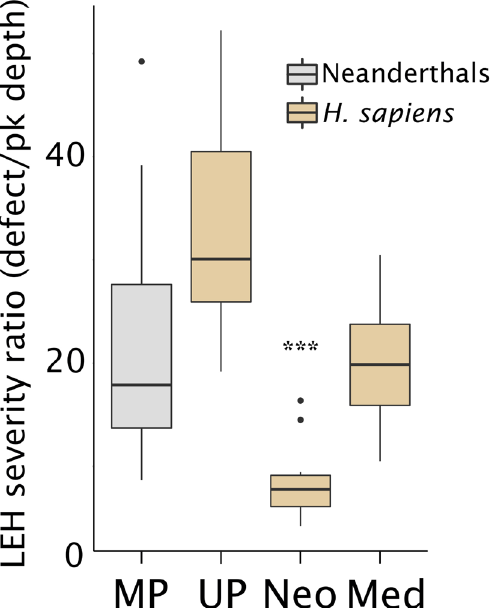
Figure 3. Severity ratios by sample. Ratios are calculated by dividing defect depths by perikymata depths from the same teeth (N = 59), or median perikymata depth for the species and tooth type where perikymata were not well-preserved enough to reliably measure (N = 12). The Neolithic sample from Çatalhöyük (Neo) has significantly lower severity ratios compared to the Medieval (Med), Upper Paleolithic (UP), and